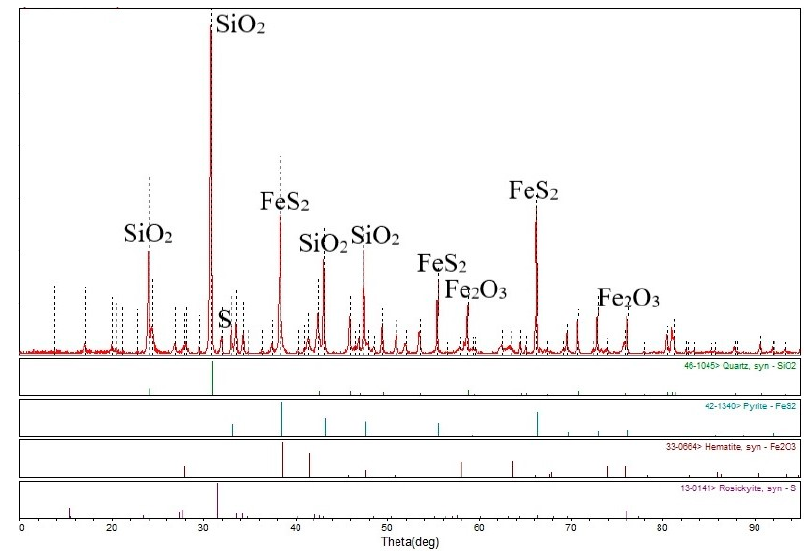
Figure 8. XRD pattern of leached residual of two-stage study (No. 1 bioleaching